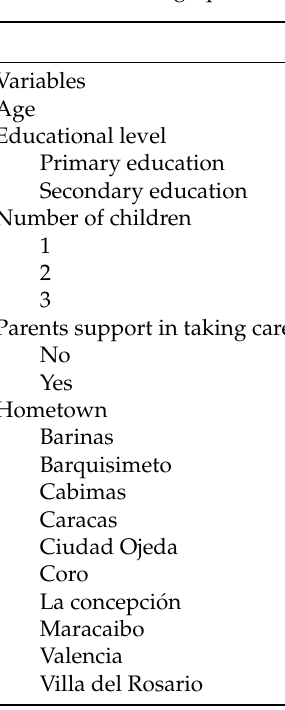
Table 1. Sociodemographic